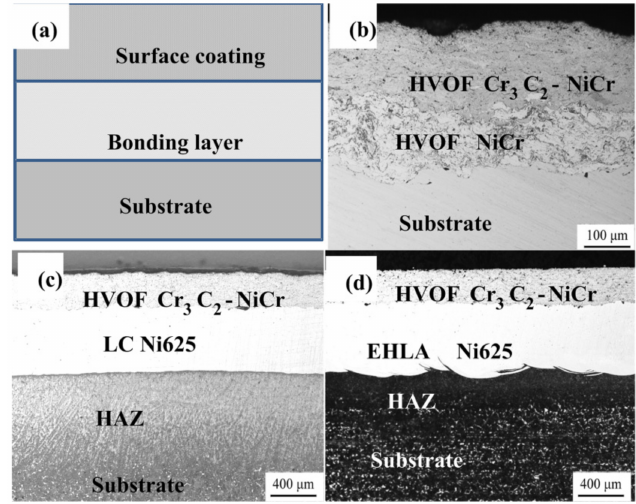
Figure 3. ( a ) The sketch of the complex coating; ( b – d ) presents the cross section of Cr 3 C 2 –NiCr + NiCr,